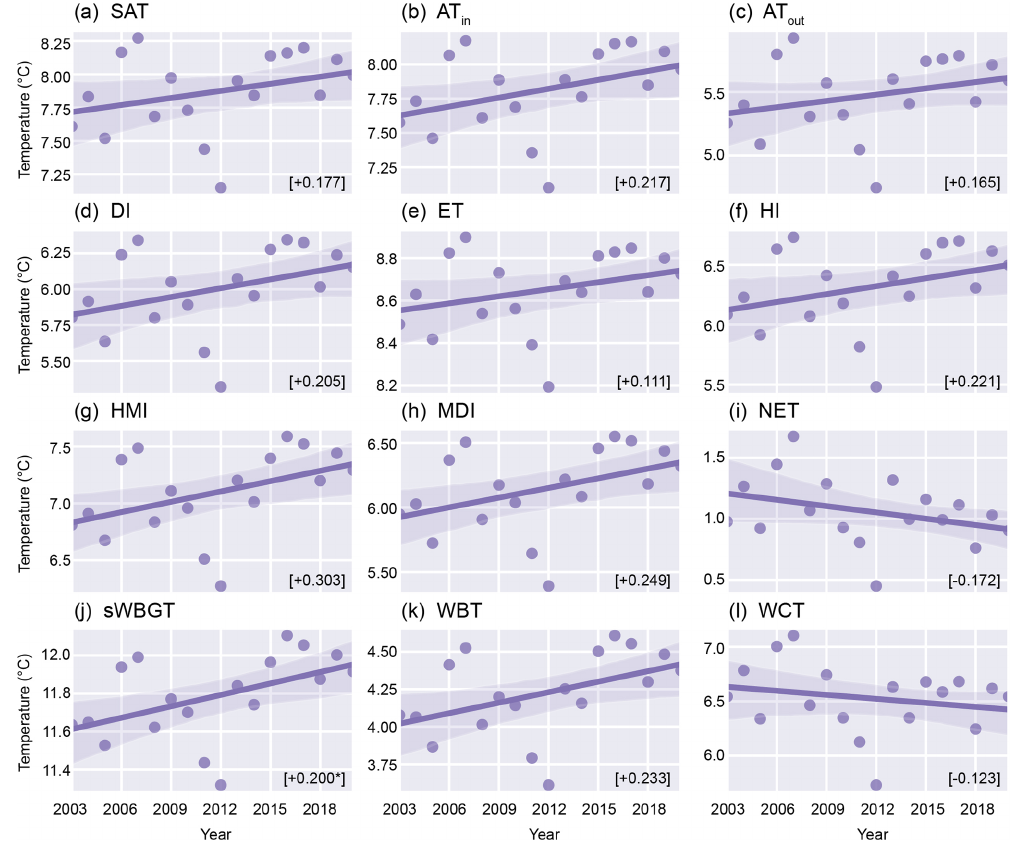
Figure 11. Temporal changes of the 12 annually averaged human thermal indices over the mainland of China during 2003–2020. The line illustrates the linear trend, the number in the square bracket means the corresponding trend per decade, and the asterisk next to the number indicates that the trends are significant at the 0.05